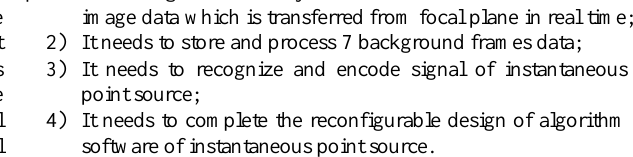
Figure 1. Principle of instantaneous point source target detection system